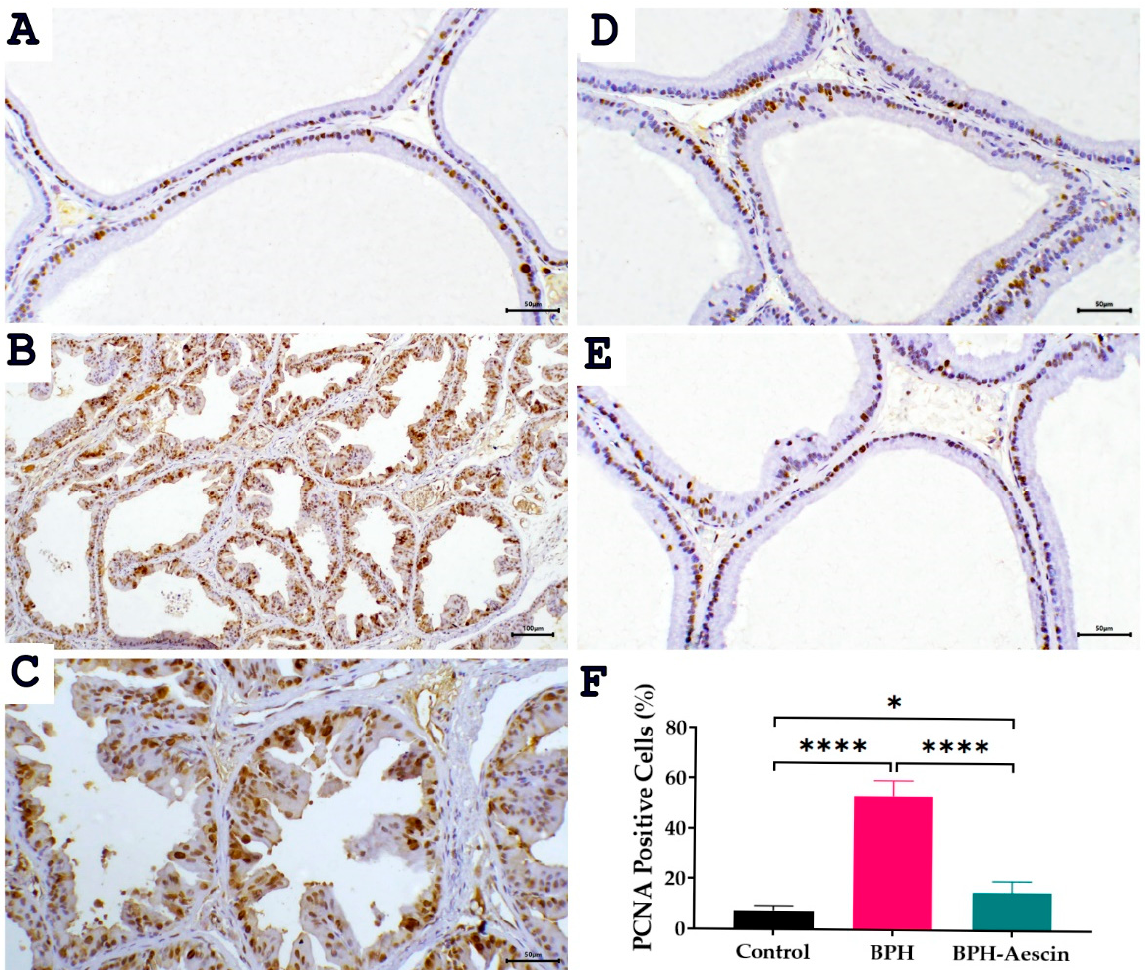
Figure 6. Effect of aescin treatment on the expression of prostate PCNA. The representative photomicrographs show immunohistochemical staining of proliferating cell nuclear antigen (PCNA) in prostate tissues among various studied groups. ( A ): Normal prostate tissue showing focal nuclear expression of PCNA staining among the epithelial cells (( A ), 200 × ). The prostate tissue of the untreated BPH group shows a marked increase in PCNA immunostaining (( B ), 100 × and ( C ), 200 × ). Prostatic tissue from animal groups treated with aescin (( D ) and ( E ) 200 × ) show less frequent immunostaining of PCNA. Quantitative analysis of PCNA expression in rat prostates among different studied groups is also shown ( F ). Significant elevation in the frequency of PCNA positive cells was observed within prostatic acini in the untreated BPH group compared with the normal control group, which was significantly decreased by aescin treatment. Data in the bar chart (mean ± SEM of 5 tissues) were analyzed by one-way ANOVA followed by Tukey’s multiple comparisons test. * and **** denote significant differences between the selected study groups at p values < 0.05 and 0.0001, respectively.